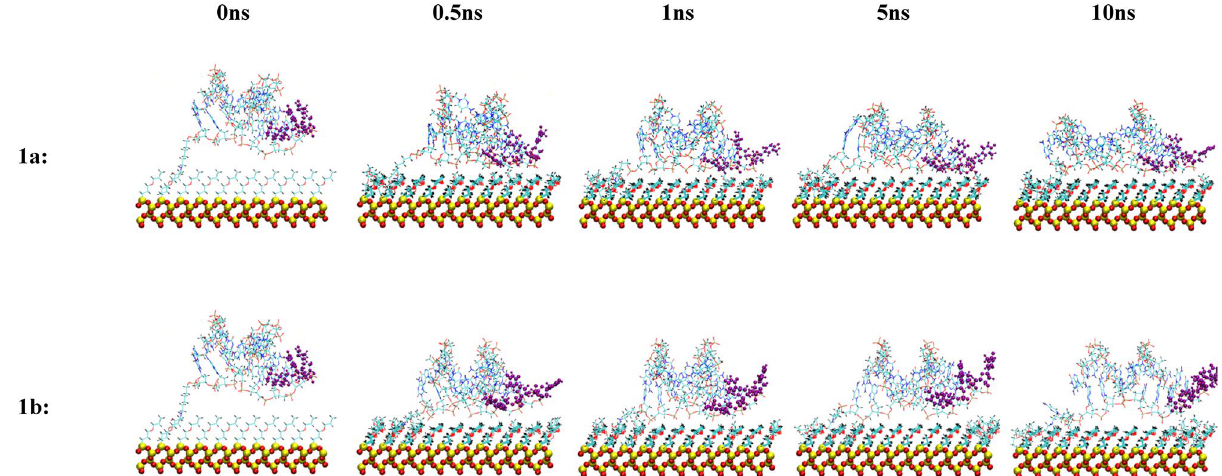
Figure 8. Snapshots of the MD simulation of the anti MUC1 aptamer tethered to the SiO 2 biosensor substrate in configuration 1 (5 ′ end attachment, parallel to surface, low density) neutralized (top) and in 0.8 M (bottom) solution concentrations at 0 ns, 0.5 ns, 1 ns, 5 ns, and 10 ns. The MUC1 binding residues (thymine residues 11 and 13) are displayed in